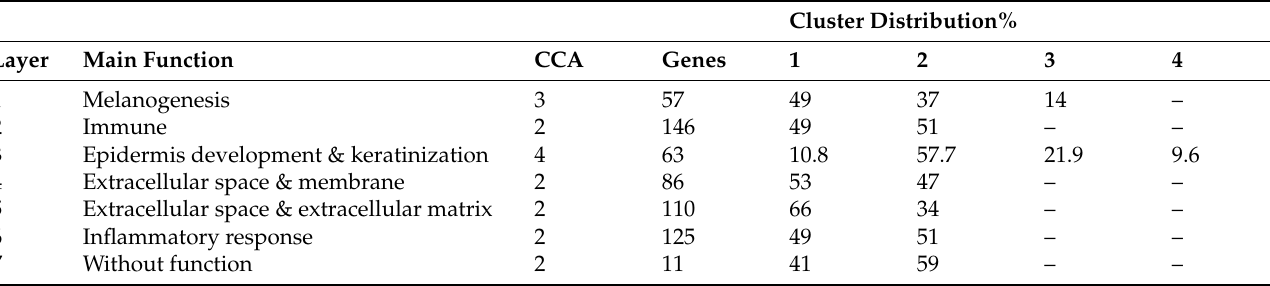
Table 1. Summary of defined biological layers. CCA: Number of groups determined by consensus cluster algorithm.